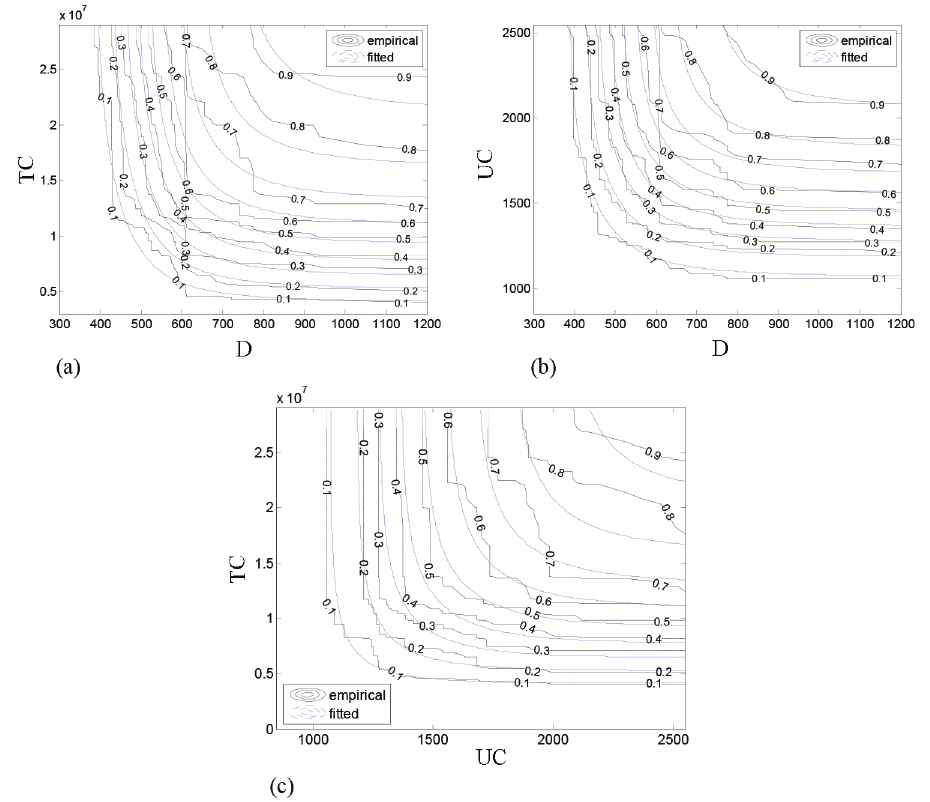
Figure 5. Comparison of contours of the empirical distribution and the Nataf distribution in dimensions: (a) TC-D dimension; (b) UC-D dimension, and (c) TC-UC